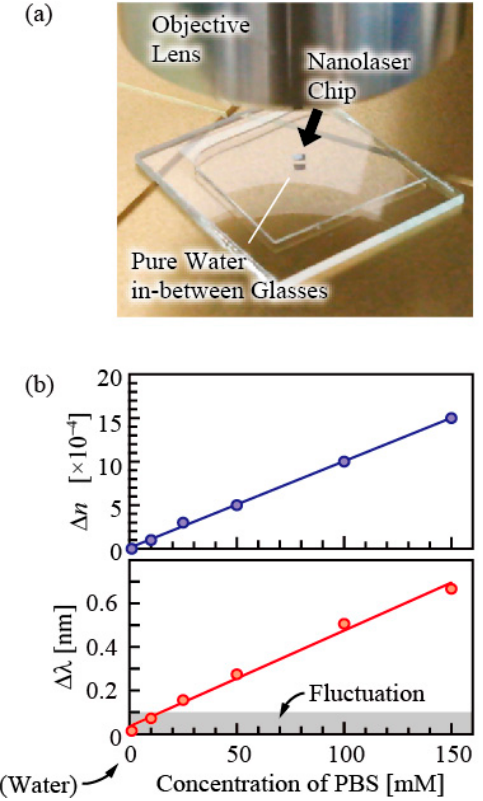
Figure 4. Liquid sensing with a nanolaser. ( a ) Overview of the measurement. ( b ) Refractive indexes of PBS at various concentrations measured using an Atago PAL-PI refractometer and wavelength shift of the nanolaser when immersed in them.